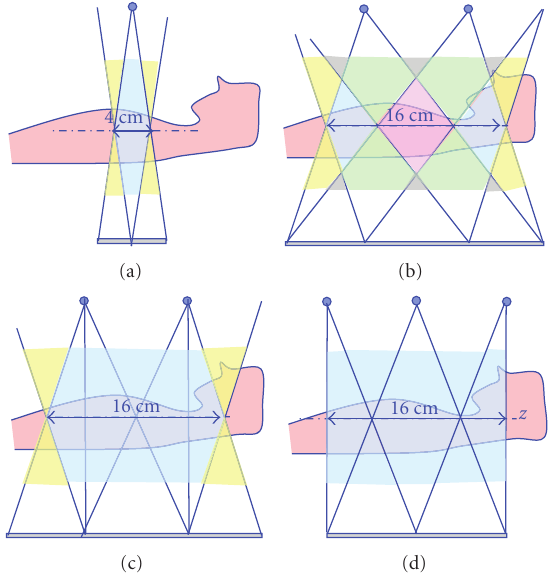
Figure 4: The flux uniformity of the various CT architectures and associated reconstruction approaches: (a) 3rd generation CT with FDK reconstruction, (b) line source CT with FDK slice substitution approach, (c) line source CT with TOM windowing reconstruction, and (d) multi-source inverse geometry CT with TOM windowing approach. The areas with di ff erent flux level are shown in di ff erent